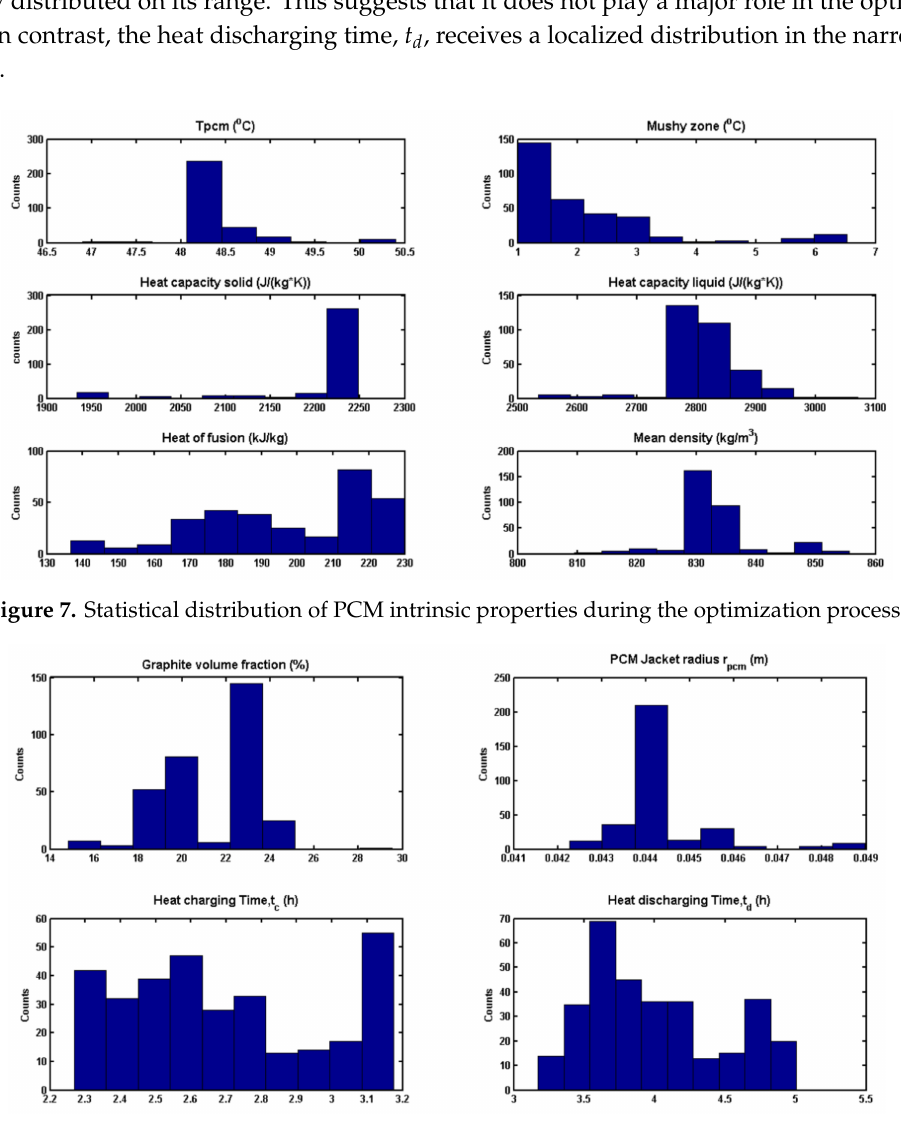
Figure 8. Statistical distribution of the operating parameters for the thermal energy storage